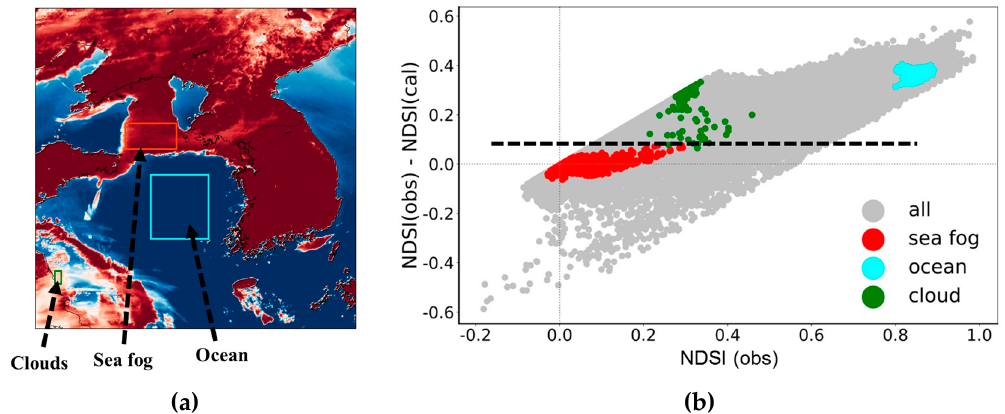
Figure 4. ( a ) Area selection of sea fog, clouds, and sea surface in the (cid:1840)(cid:1830)(cid:1845)(cid:1835) (cid:3042)(cid:3029)(cid:3046) data. ( b ) Distributions of sea fog, clouds, sea surface pixels, and all pixels in the Yellow Sea in the (cid:1840)(cid:1830)(cid:1845)(cid:1835) (cid:3031)(cid:3036)(cid:3033)(cid:3033) - (cid:1840)(cid:1830)(cid:1845)(cid:1835) (cid:3042)(cid:3029)(cid:3046)